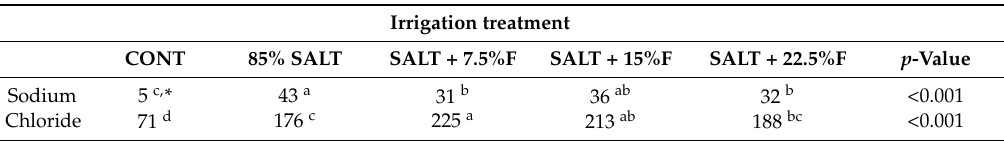
Table 3. The effect of irrigation treatment on the sodium and chloride concentration (mmol/kg dry weight) in tubers harvested on 92